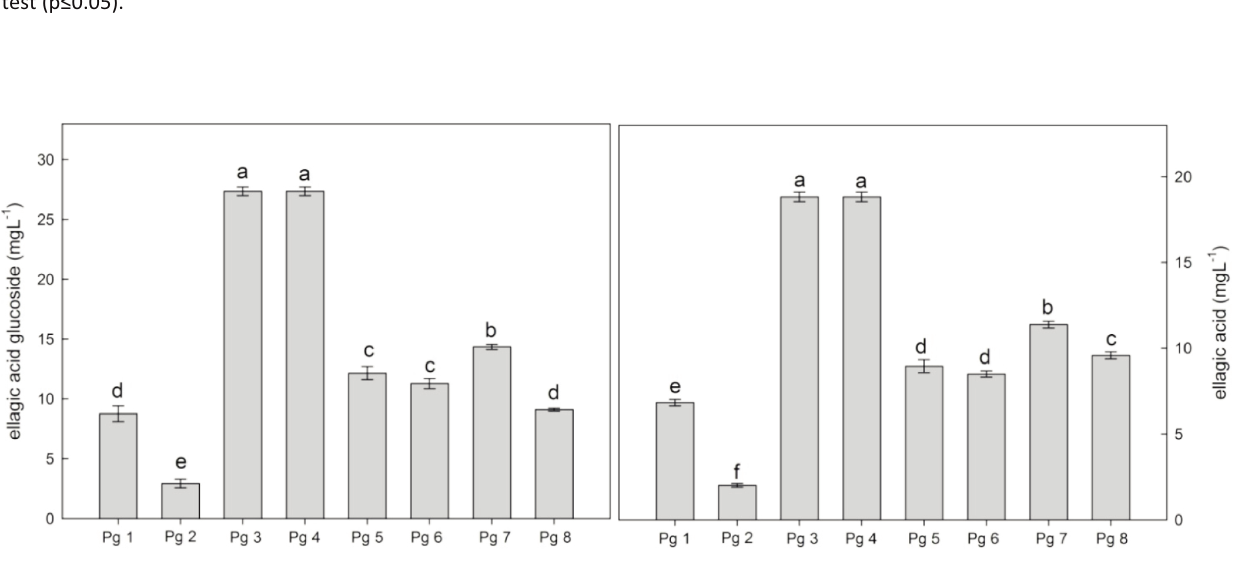
Fig. 4 ­ Concentration of ellagic acid glucoside and ellagic acid in the juices obtained from pomegranate fruits of the different accessions. The bars indicate the standard deviation (n=3). Different lowercase letters indicate significant differences according to Tukey’s test (p ≤